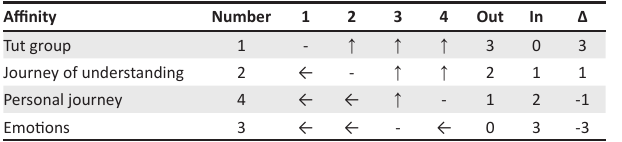
TABLE 3: Tabular inter-relationship diagram sorted in descending order of Δ . Affinity